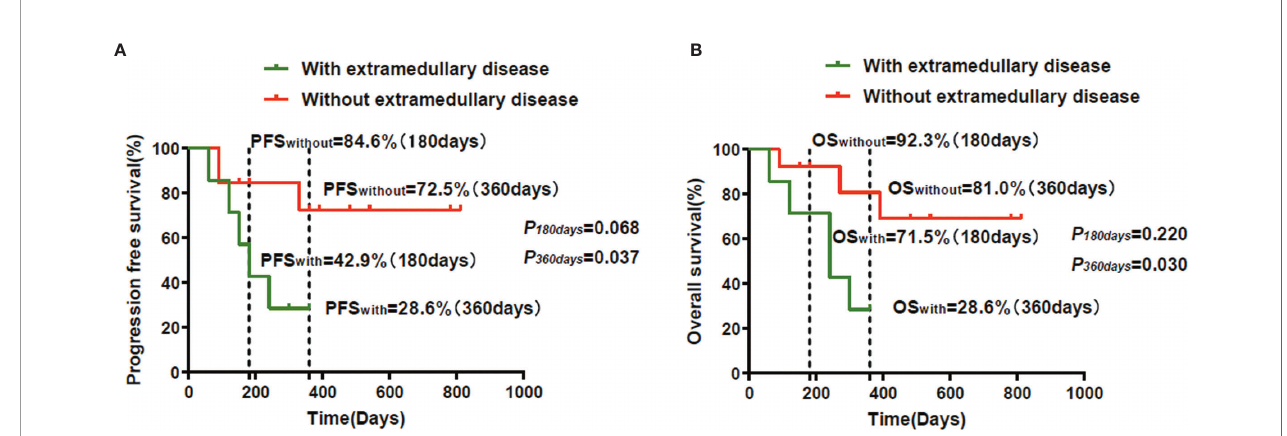
FIGURE 2 | The survival observation of the humanized anti-BCMA CAR-T cell therapy. (A) The PFS in patients with extramedullary disease was lower than that of the patients without extramedullary disease at 360 days ( P =0.037). There was no difference of the PFS in the two groups at 180 days ( P =0.068). (B) The OS in patients with extramedullary disease was lower than that of the patients without extramedullary disease at 360 days ( P =0.030). There was no difference of the OS in the two groups at 180 days ( P